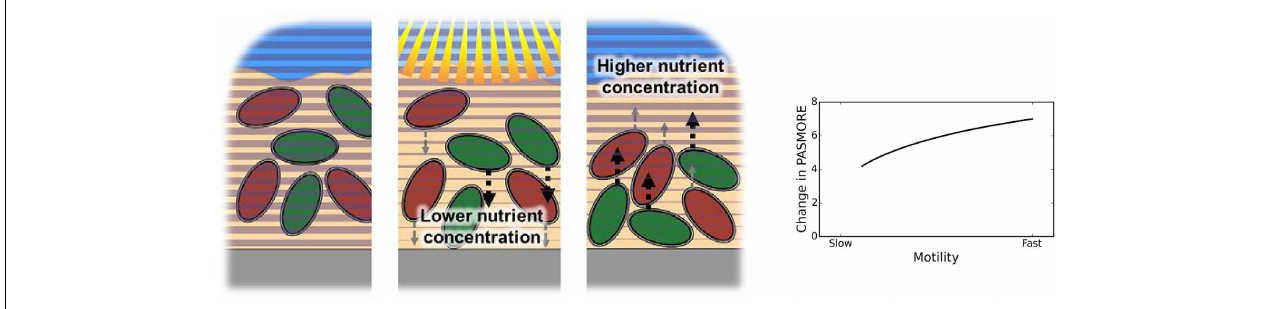
FIGURE 6 | Schematic of the model system, which has been modified to force competition between two species (one with higher resilience and one with lower resilience) by making motility dependent on consumption of a sole nutrient, which is supplied in the liquid above the microbial mat. During a perturbation, the nutrient concentration far from the perturbation becomes limited. The right plot shows the percent change of PASMORE when a slower species competes for the nutrient with a faster species, compared to a non-interacting case (i.e., when the species rely on differing nutrients). The competitive interaction led an increase in PASMORE, i.e., lower resilience, for both the slow and fast species due to the competition between species. The faster species exhibited a greater decrease in resilience compared to the slower